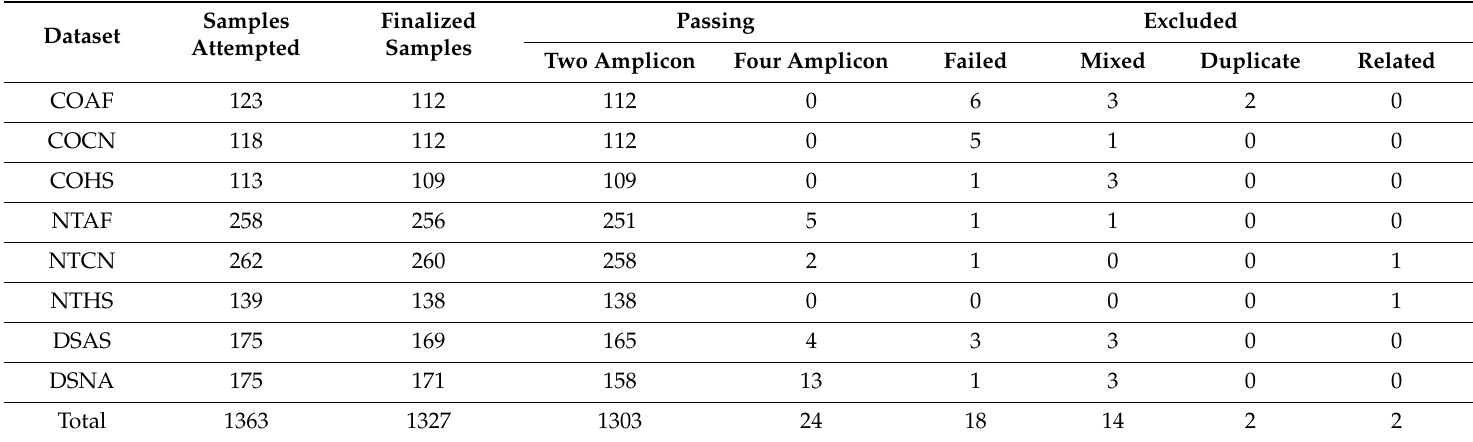
Table 3. Breakdown of sample success rate by dataset.